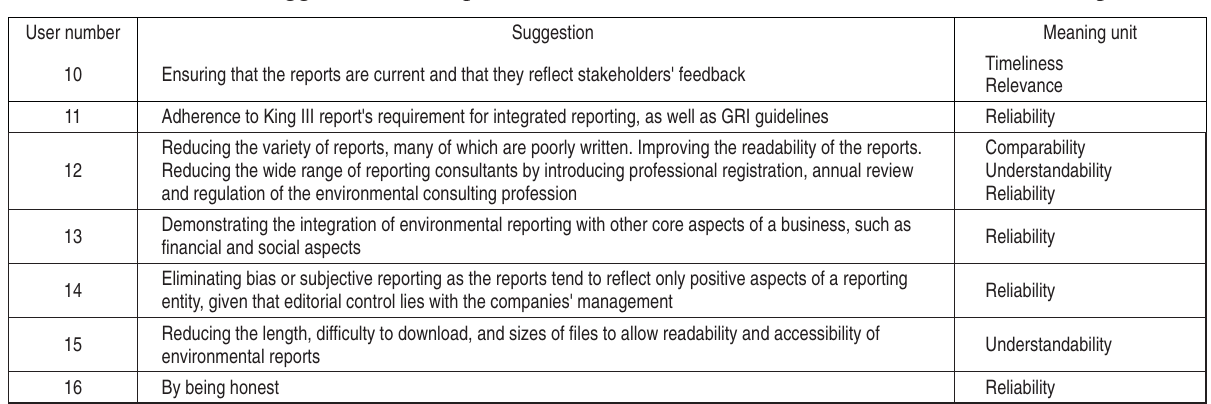
Table 6 (cont.). Users’ suggestions for improvement of the decision-usefulness of environmental reports